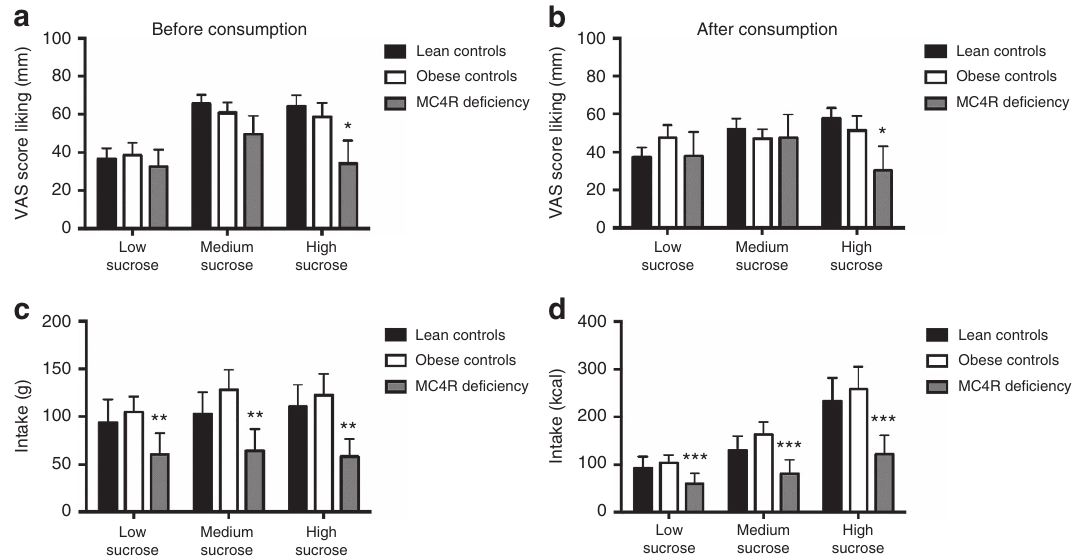
Figure 2 | Liking ratings and food intake in the sucrose preference test. Liking of low, medium and high sucrose food before ( a ) and after ( b ) an ad libitum meal test in lean controls ( n ¼ 20), obese controls ( n ¼ 20) and individuals with MC4R deficiency ( n ¼ 10). Liking ratings for the high sucrose meal were significantly reduced in MC4R deficiency. Means ± s.e.m. (error bars) are shown. Results were analysed using a linear mixed-effects model. ** P ¼ 0.0252. Total intake (g and kcal; c , d respectively) in lean controls, obese controls and individuals with MC4R deficiency. ** P ¼ 0.0064 and *** P ¼ 0.0031 for group in a linear mixed-effects